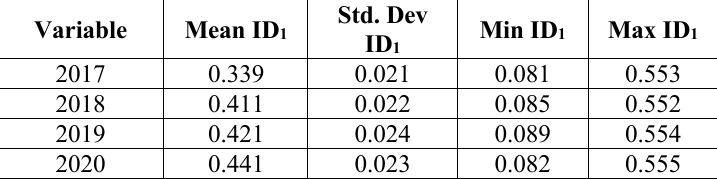
Table 8. Descriptive statistics ID (1;2) index from 2017 to 2020